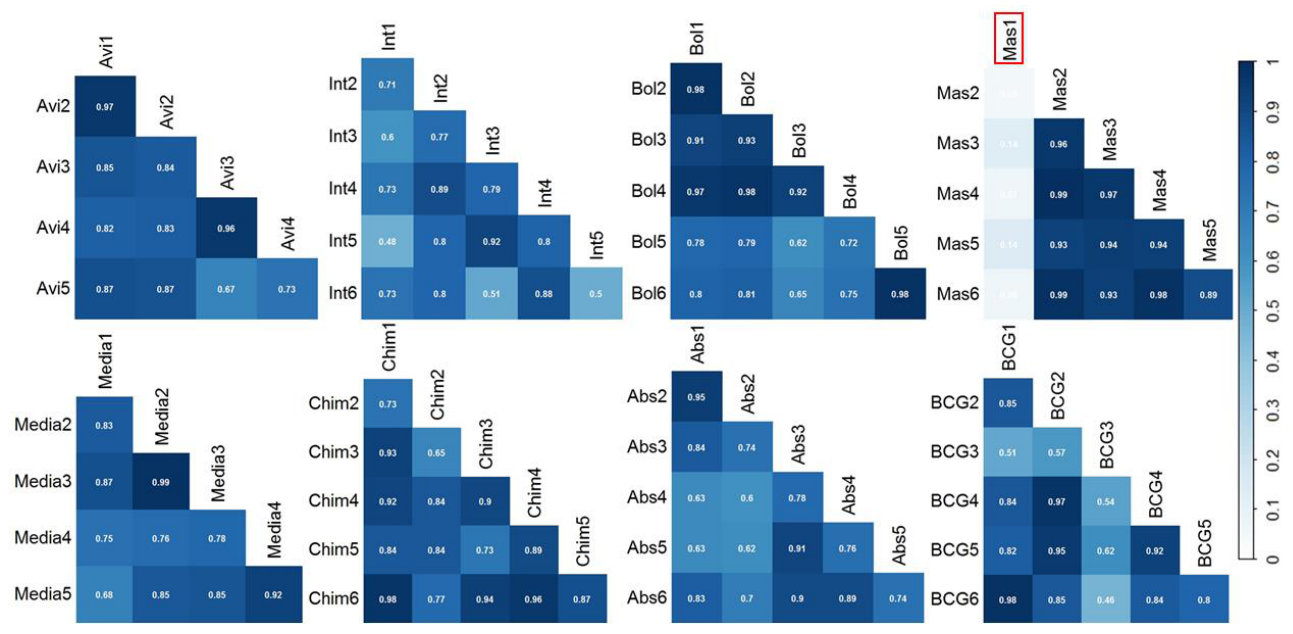
Figure 2. Pearson’s correlation coefficients plot obtained for each mycobacterium specie. Abs—M. abscessus ; Avi—M. avium ; BCG—M. bovis ; Bol—M. bollettii ; Chim—M. chimaera ; Int—M. intracellulare ; Mas—M. massiliense ; Med—growth media. The number following the abbreviation stands for the replicate number. An outlier—The sample circled in red (Mas1, top right) resulted as an outlier and was excluded from further data elaboration.